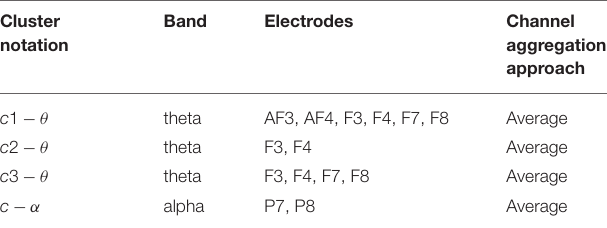
TABLE 1 | Clusters and electrode combinations from frontal and parietal cortical regions selected from the available electrodes. Cluster